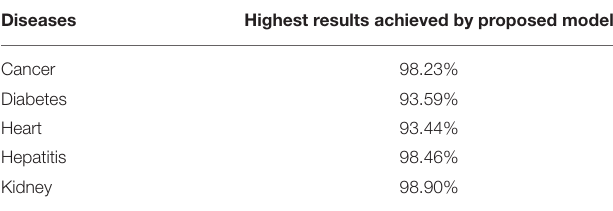
TABLE 3 | Highest accuracy achieved by proposed